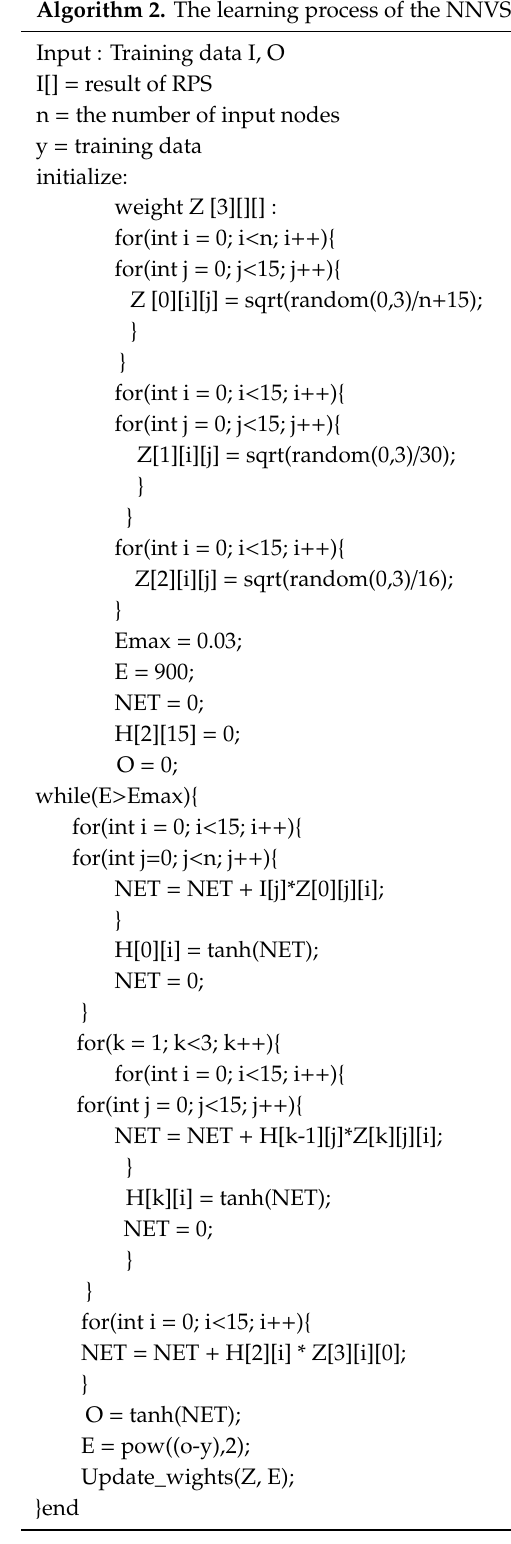
Algorithm 2. The learning process of the